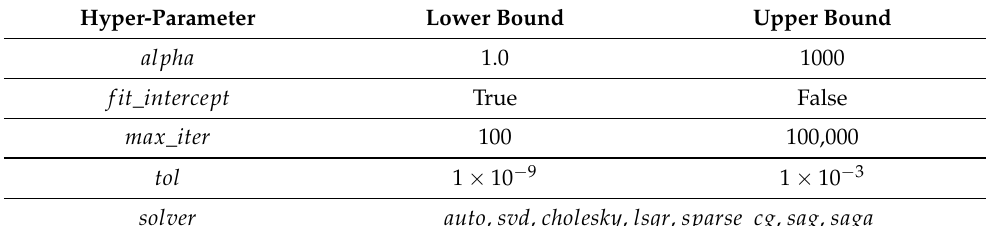
Table 11. An overview of the used hyper-parameter range for Ridge Regression